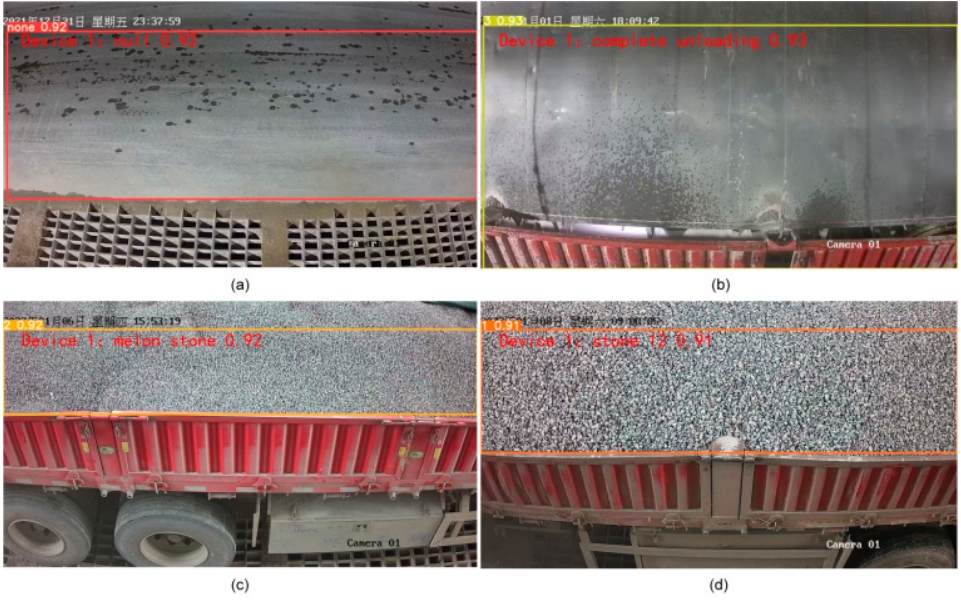
Figure 11. Examples of on-site aggregate inspection applications. ( a ) is the unloaded state, ( b ) is the state of completion of unloading, ( c ) represents that the aggregate is melon stones, ( d ) represents that the aggregate is 12 stones.